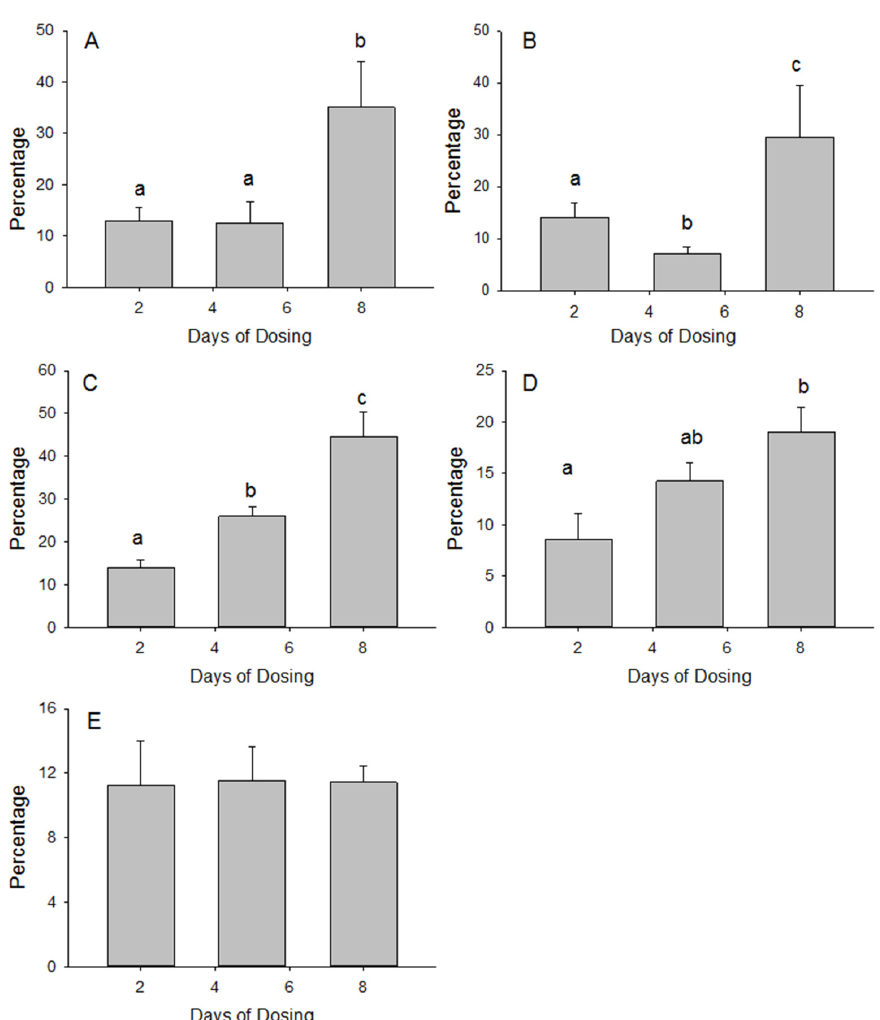
Figure 1. The percentages of 35 S activity (DPM/ μ L) in the serum ( A ) and in homogenates of the blood cells ( B ), liver ( C ), small intestine ( D ) and skeletal muscle ( E ) of mice that were recovered in the corresponding protein gels (DPM in the gels were normalized to the volume of serum and homogenates loaded onto the gels) after supplementing the diet with 35 S labeled MSM for 2, 5 and 8 days. Bars with different letters are significantly different ( p < 0.05).